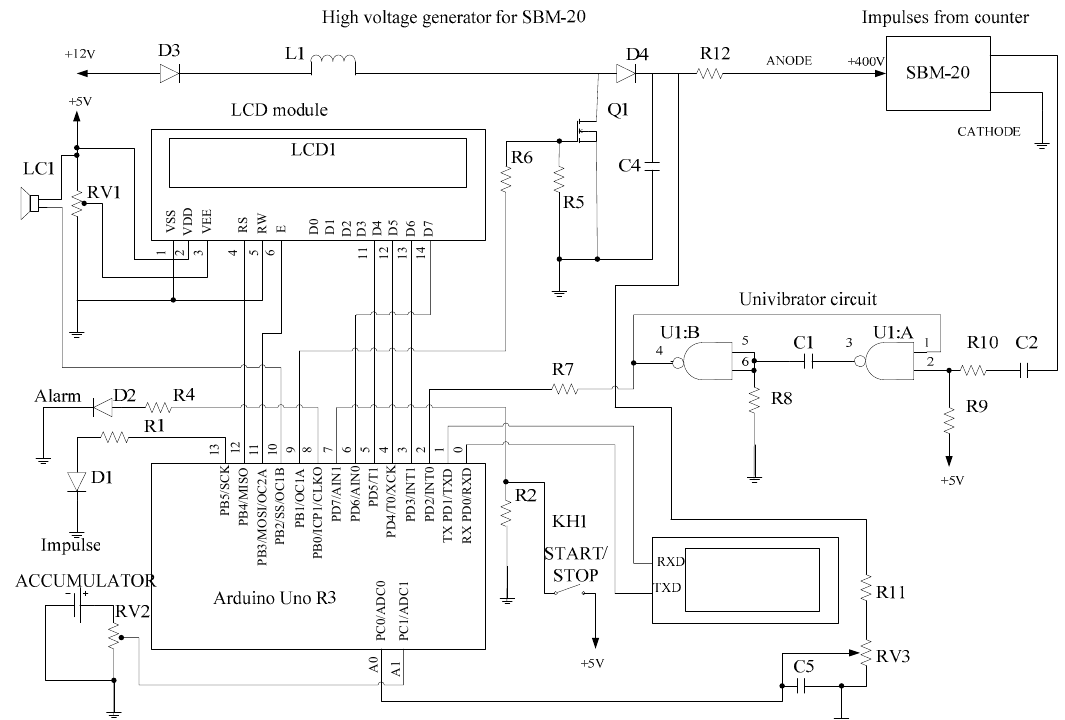
Figure 6. Circuit diagram of the Arduino microcontroller based system for radiation monitoring [15]. As the radiation power increases more than the permissible norms (0.3 µ Sv / h), the sound (LS1 buzzer) and the light (the red LED “Alarm” blinks) alerts are switched on. The indication of the intensity of the radiation impulses occurs with the blue LED1. In the LCD module the information about the radiation power in µ Sv / h and CPM (counts per minute) is continually displayed.